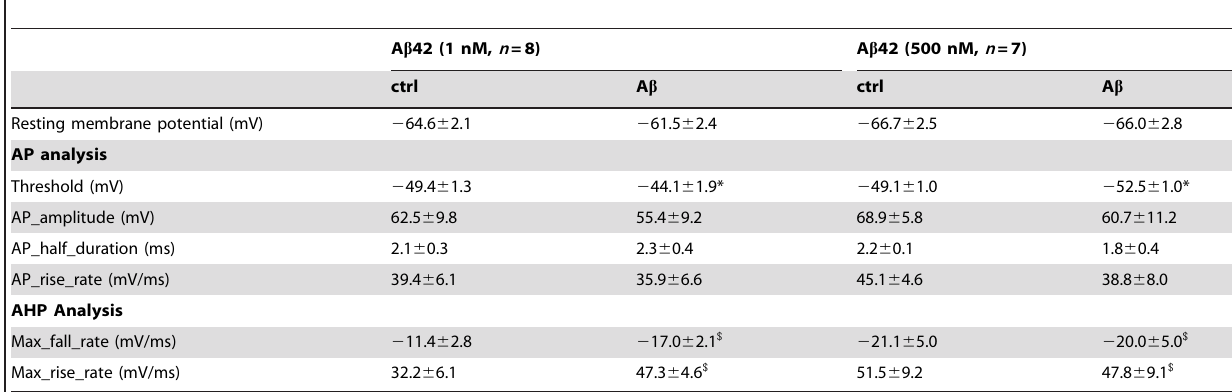
Table 1. Changes in intrinsic membrane properties of PCs by prolonged application of low and high dose A b